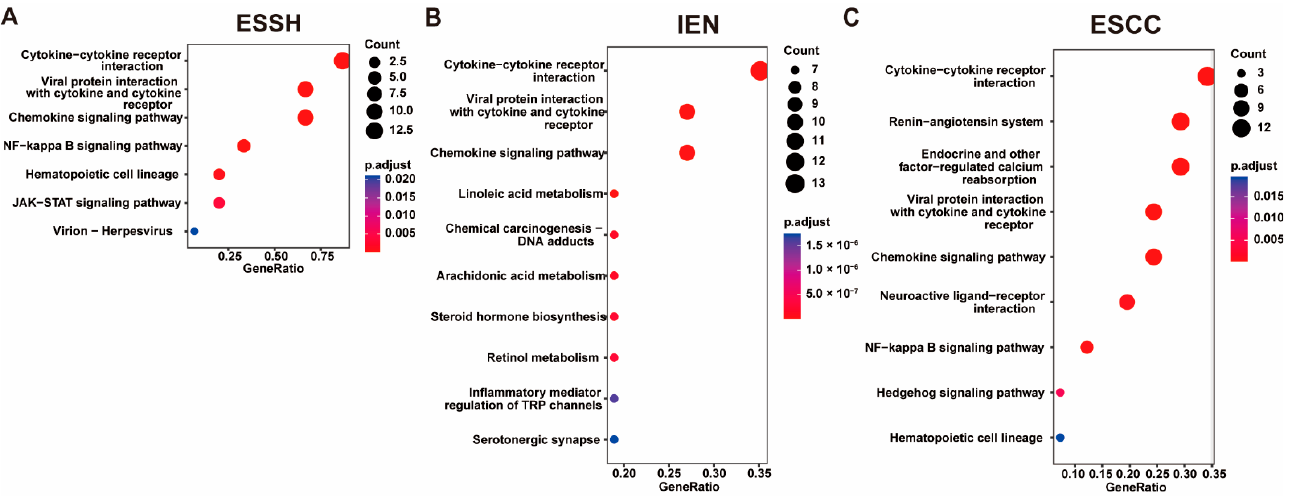
Figure 5. KEGG enrichment of CNV genes. (( A – C ) TOP 10 KEGG pathway of ESSH, IEN, ESCC stage).